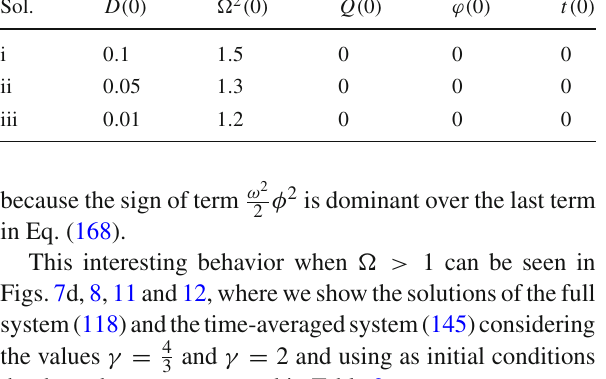
Fig. 11 Some solutions of the full system (118) (blue) and time- Fig. 12 Some solutions of the full system (118) (blue) and time- averaged system (145) (orange) for the FLRW metric with positive averaged system (145) (orange) for the FLRW metric with positive curvature ( k = + 1) when γ = 4 curvature ( k = + 1) when γ = 2. We have used for both systems the . We have used for both systems the 3 initial data sets presented in Table 2 initial data sets presented in Table 2 Table 2 Here we present three initial data sets for the simulation of full system (118) and time-averaged system (145) for FLRW metric with positive curvature ( k = + 1) and for γ = 4 (radiation) and γ = 2 (stiff 3 fluid). All the conditions are chosen in order to fulfill the inequalities (cid:8) > 1 and 0 ≤ Q ≤ 1